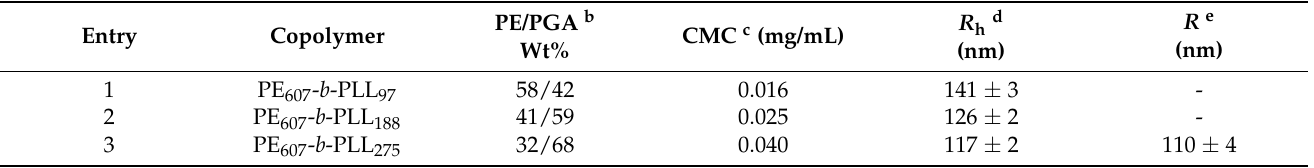
Figure 4. I I /I III ratios from the pyrene emission spectra versus the logarithm of PE 607 - b -PLL 275 concentrations. Table 2. Characterizations of PE- b -PLL polymeric micelles self-assembled in water. a